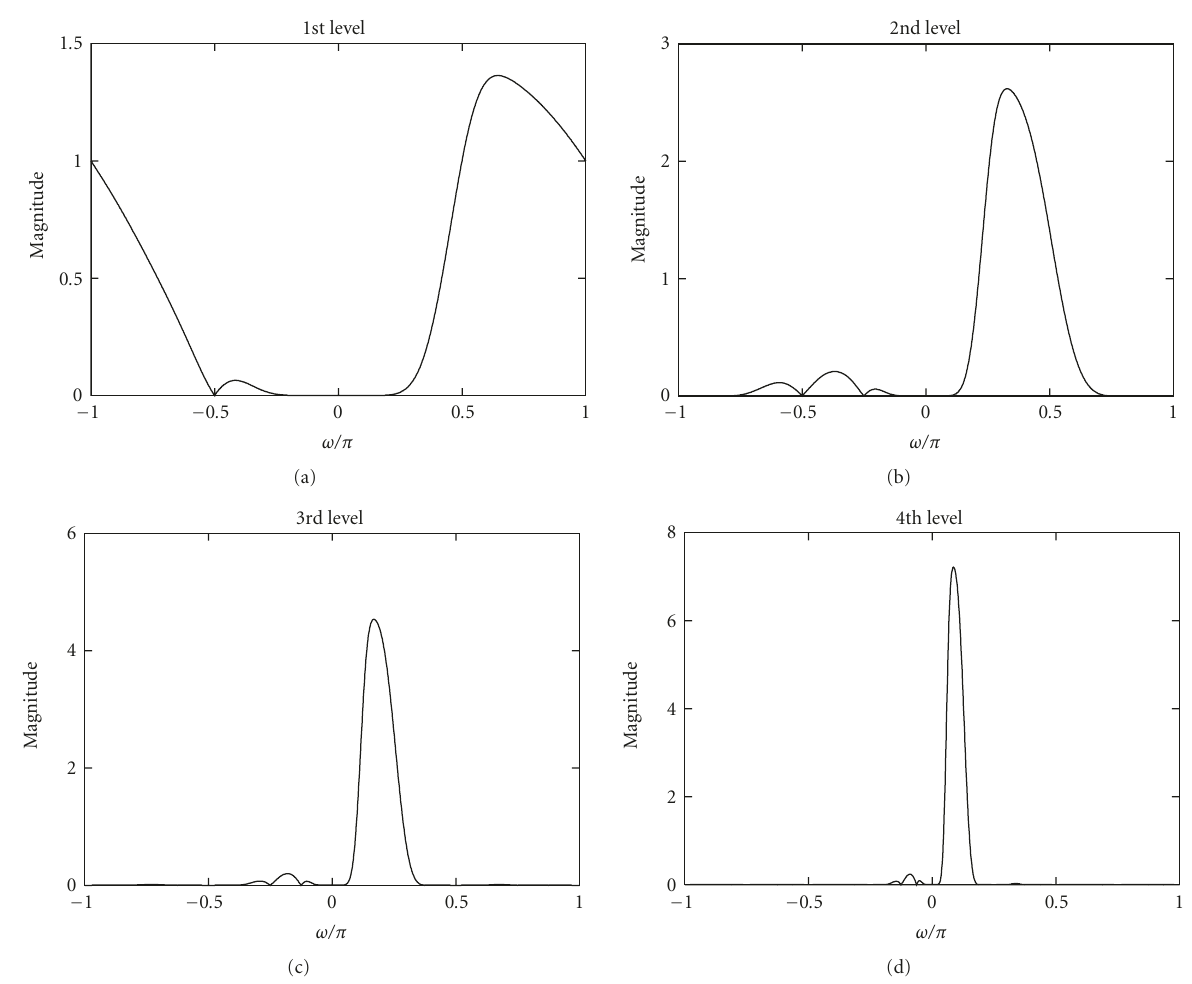
Figure 5: Frequency response of 1-dimensional wavelets in the first 4 levels for the DT-CWT (filters in first level are from daubechies “db10” filterbank and subsequent levels are filters from